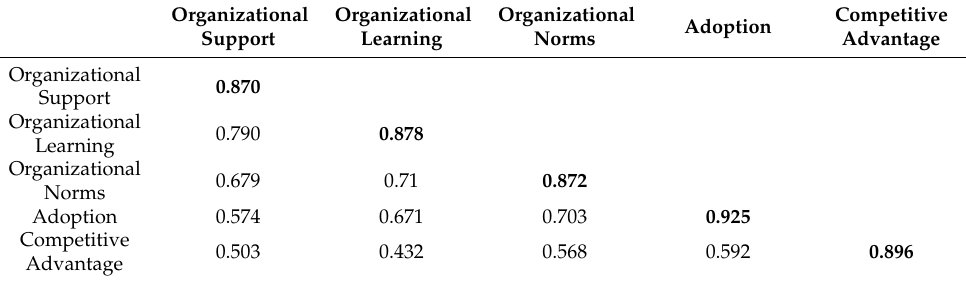
Table 3. Fornell–Larcker criterion analysis for checking discriminant validity.